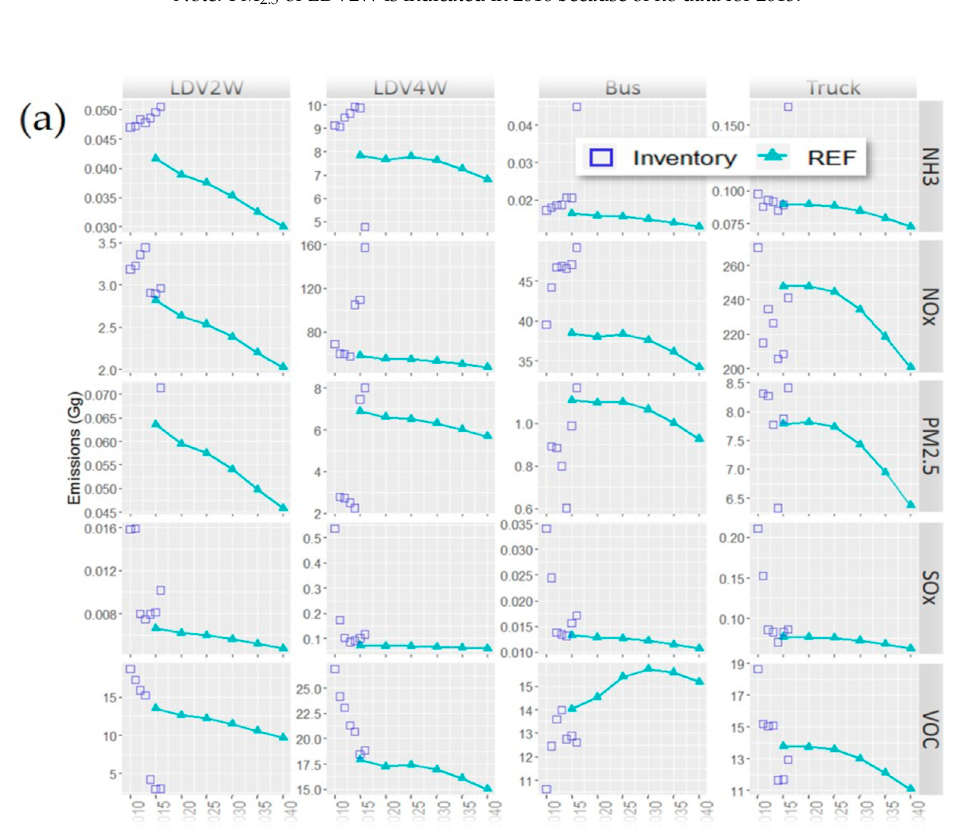
Table 4. Comparison of emissions from the national inventory and those from GCAM-Korea (2015). (Unit: Gg) LDV2W LDV4W Bus Truck